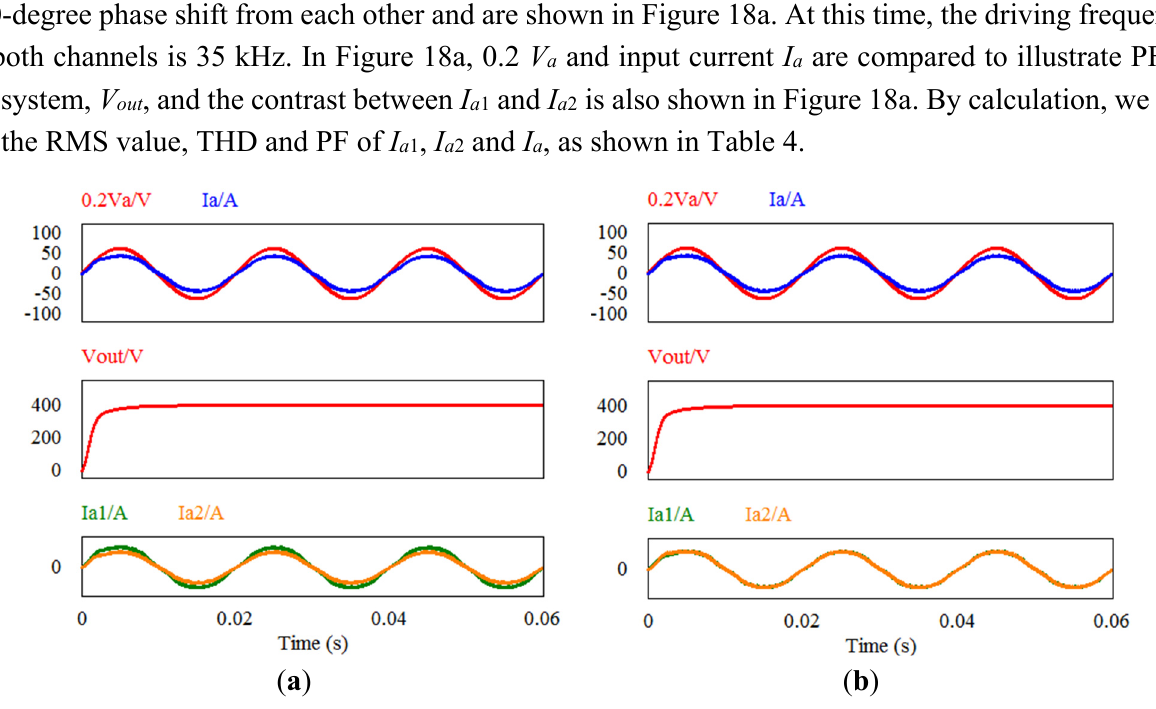
Figure 18. Simulated waveforms under the imbalanced current condition: ( a ) two channels with a synchronous drive; ( b ) the current sharing control